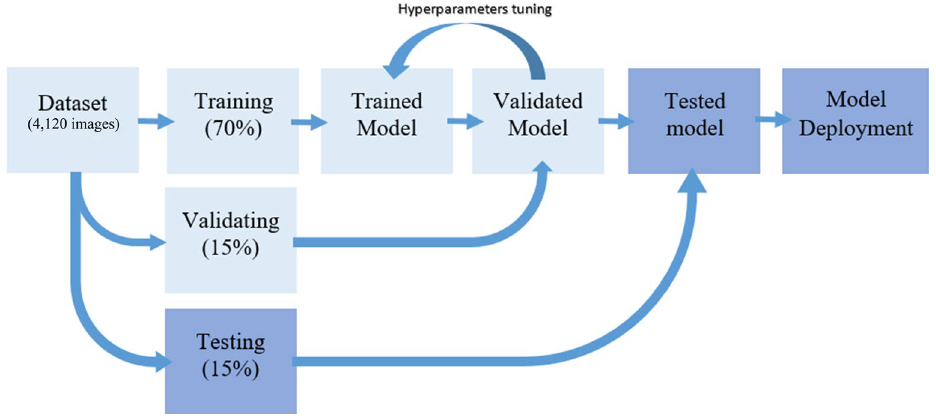
Figure 2. Data splitting and process to be used for training, validating and testing the model. The dataset of 4,120images is split into 70% training (2,884 images), 15% validation (618 images) and 15% testing 618 images).